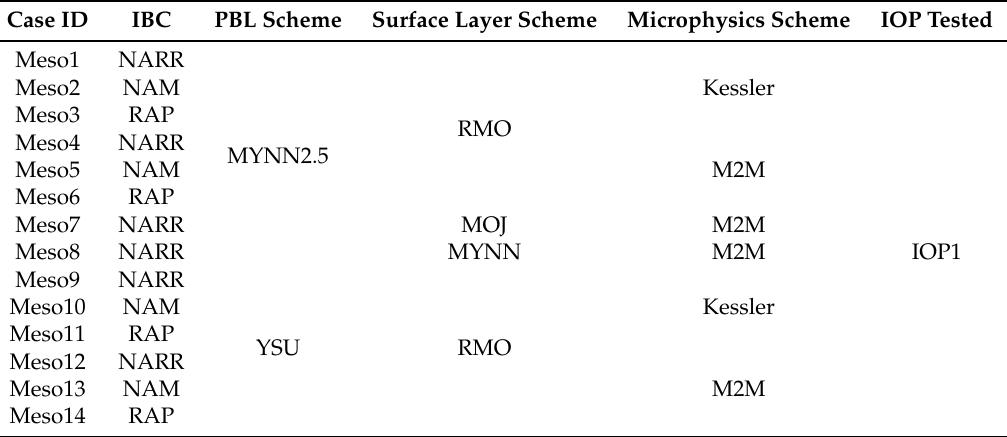
Figure 1. ( a ) Mesoscale simulation domains configured in WRF, the innermost domain is D05. ( b ) LES domains configured in WRF, the innermost domain is D06. The black arcs shown in innermost domain in ( b ) represent the SF 6 tracer sampling network and the red square represent the release location. ( c ) Vertical resolution of coarse and fine LES runs simulated in this study. ( d ) Part of domain D06 showing the locations of Wind profilers, Grid 3 Tower (GRI) and Release location during PSB1. The blue dots represent the 3D sonic anemometers used at a radial distance of 3200 m from release location. Table 2. Combinations of WRF mesoscale simulations parameterizations included in the sensitivity